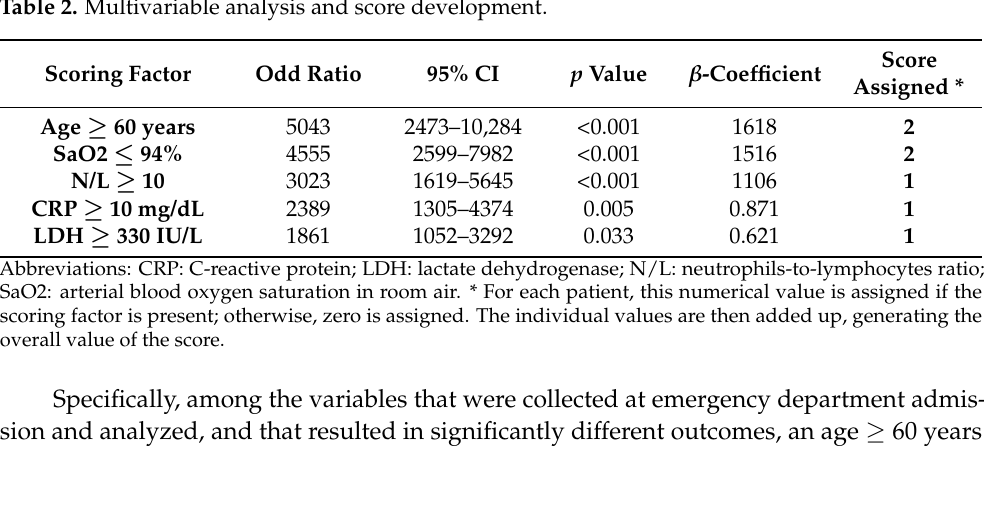
Table 2. Multivariable analysis and score